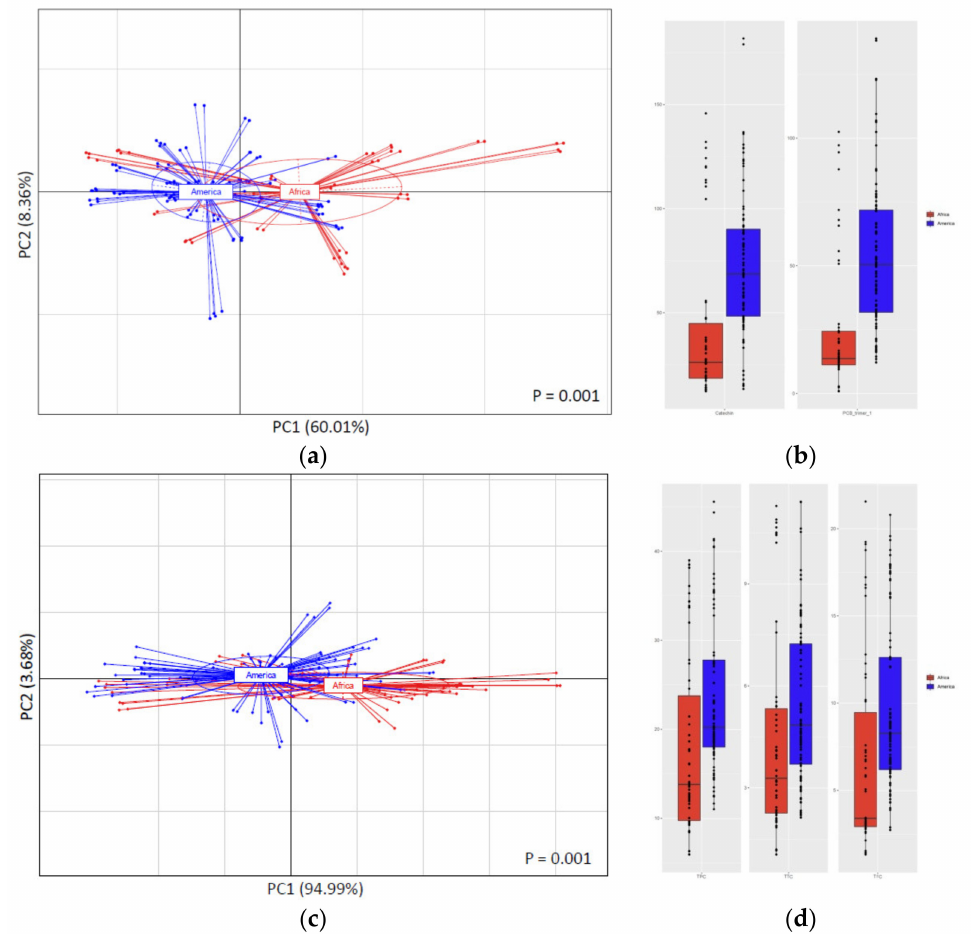
Figure 1. Principal component analysis (PCA) based on HPLC-determined polyphenolic profile ( a ) and spectrophotometric analyses results ( c ) as function of continent of origin of the CBS. Variance explained by first and second components of PCA is shown in parenthesis for PC1 and PC2 in each graph. Boxplots showing abundance of two key polyphenolic compounds (catechin and PCB trimer 1) ( b ) and total phenolic content (TPC), total tannin content (TTC), and total flavonoid content (TFC) ( d ) that can be used as possible markers for separation based on continent of origin are shown next to their correspondent PCA graph. For interpretation of legends, see Table